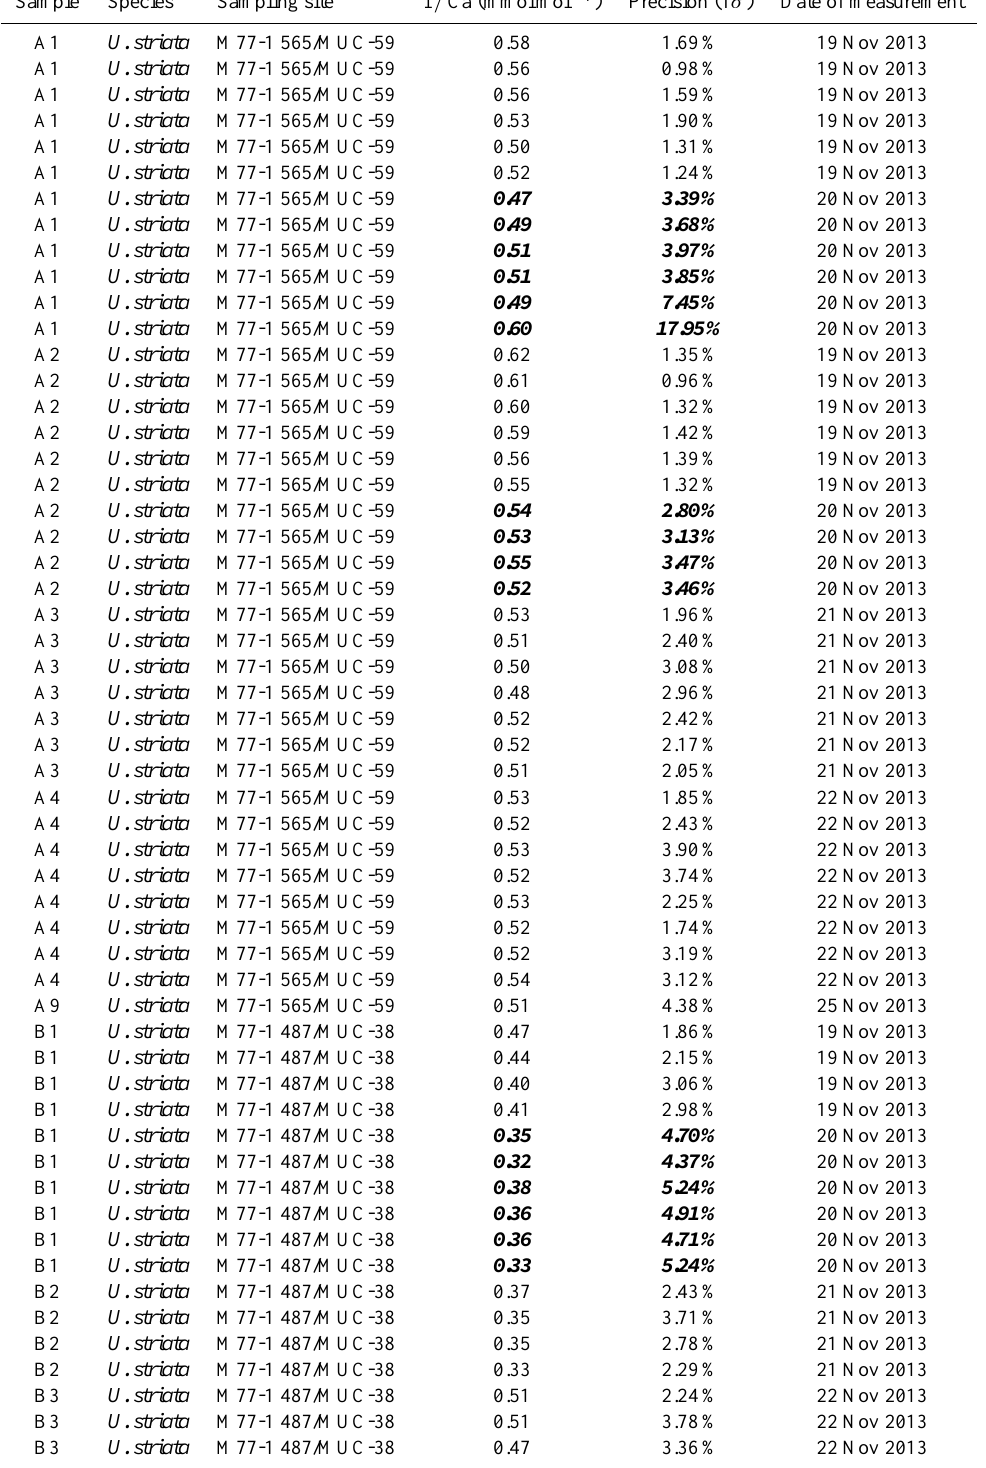
Table A2. I / Ca ratios and precision for the single measurements of the foraminiferal samples. Bold and italic numbers represent measure- ments which were done 1day after the dissolution of the